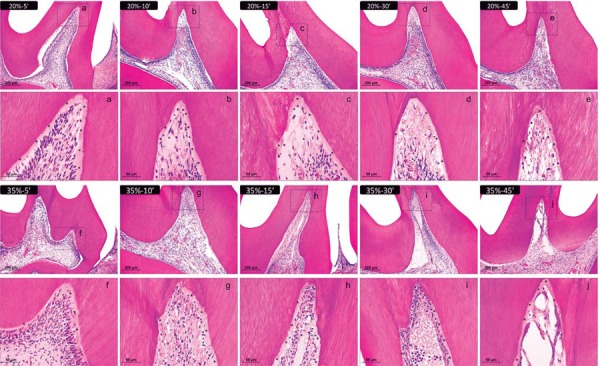
Representative images of H&E-stained sections showing the coronal pulp 2 days after bleaching. Panels a, b, c, d, and e represent the groups treated with 20% H2O2 gel and panels f, g, h, i, and j represent those treated with 35% H2O2 gel for 5, 10, 15, 30, and 45 min, respectively (×100 magnification). Panels a-j are magnified images (×400) of the insets in panels a-j, respectively. The asterisks show the predentin layer. The number of inflammatory cells and fibroblasts was obtained in each third of the pulp tissue (at 1000x magnification) and subjected to the Kolmogorov-Smirnov normality test, the Two-way ANOVA and Tukey test (p<.05); and the scores to odontoblastic layer and vascular changes to Kruskal-Wallis and Dunn test (p<0.05). H&E=hematoxylin & eosin